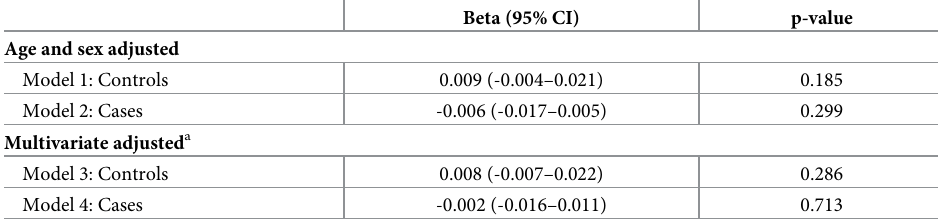
Table 7. Linear regression models for the log transformed sum of antibodies against all Neu5Gc-glycans against food diary red meat for cases and controls separately in the EPIC-Norfolk